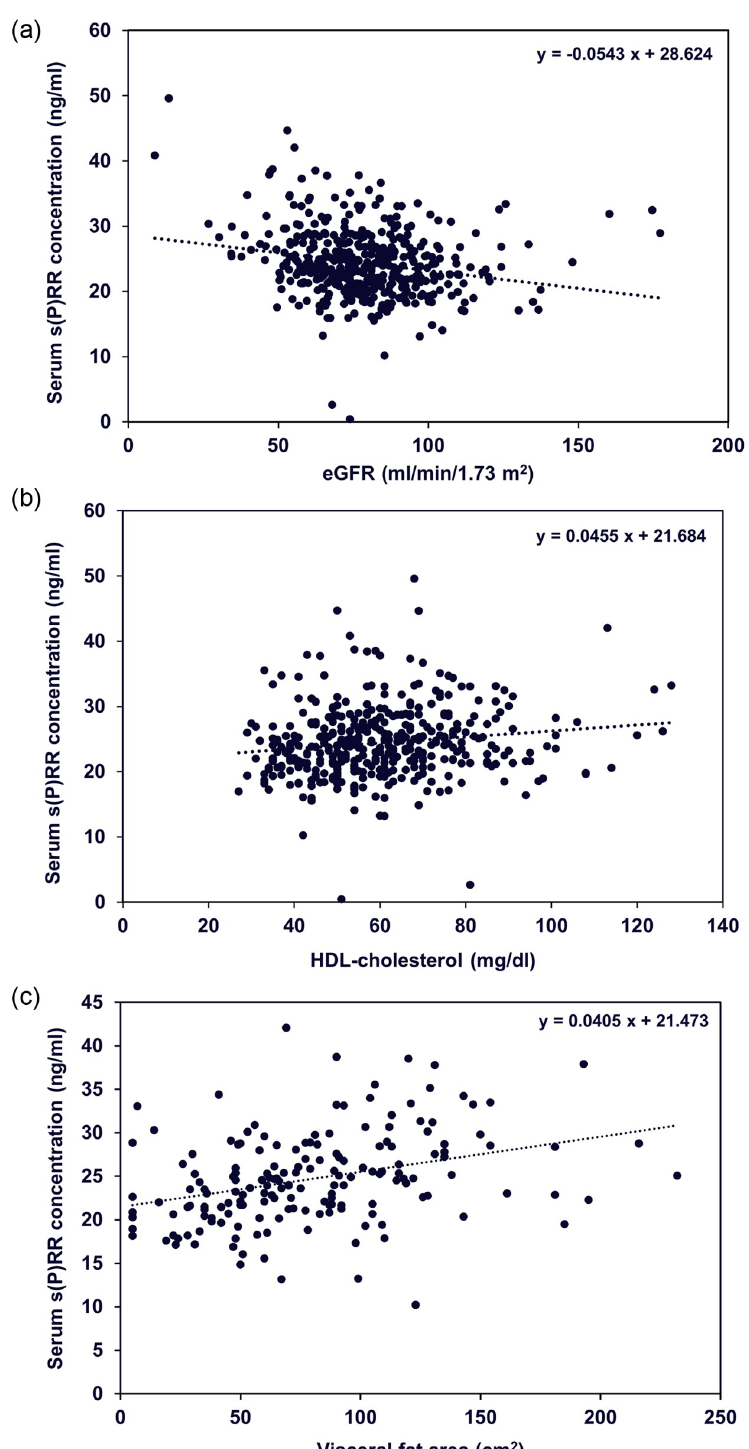
Fig 5. Scattergrams showing relationship between eGFR (a), HDL-cholesterol (b), or visceral fat area (c) and serum s(P)RR concentration. s(P)RR, soluble (pro)renin receptor; eGFR, estimated glomerular filtration rate; HDL, high-density